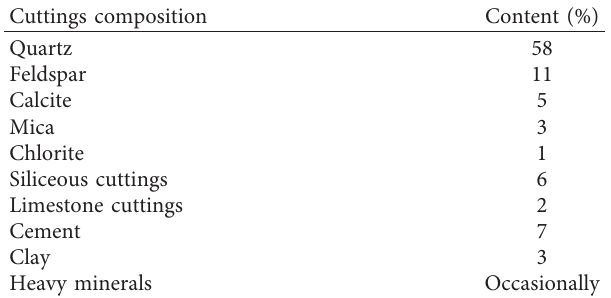
Table 1: Debris components and contents.